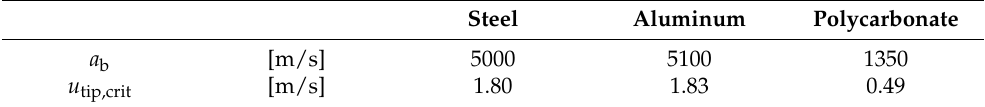
Table 4. Critical rotor tip speeds.